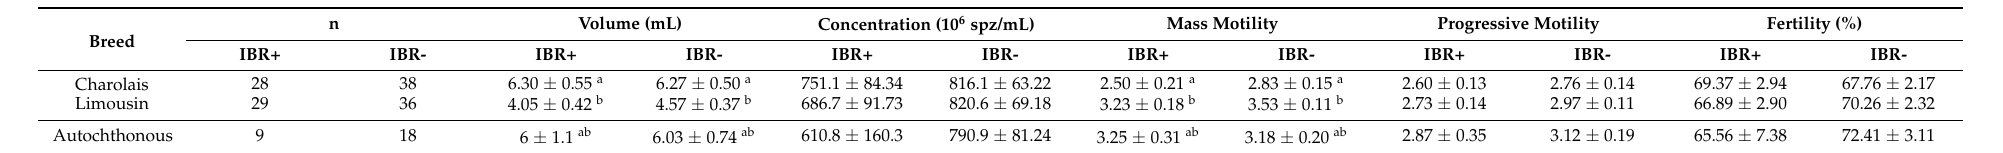
Different letters indicate statistically significant differences between breeds ( p < 0.05, One Way